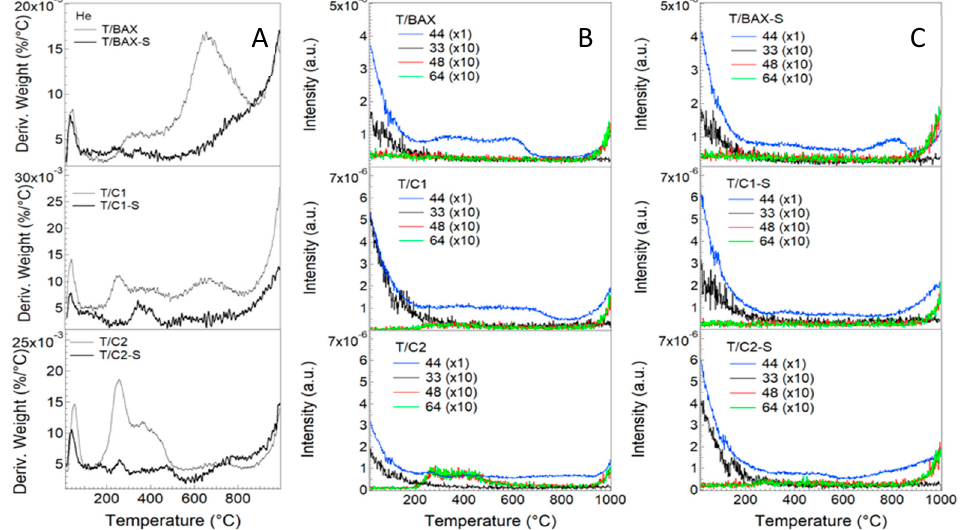
Figure 2. ( A ) DTG curves in helium; ( B ) m / z thermal profiles for the initial samples; ( C ) m / z thermal profiles for the H 2 S-treated samples.